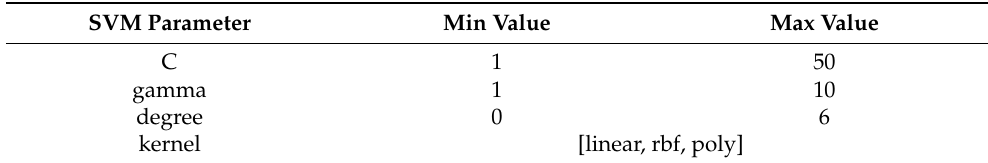
Table 7. Initial values of SVM parameters.